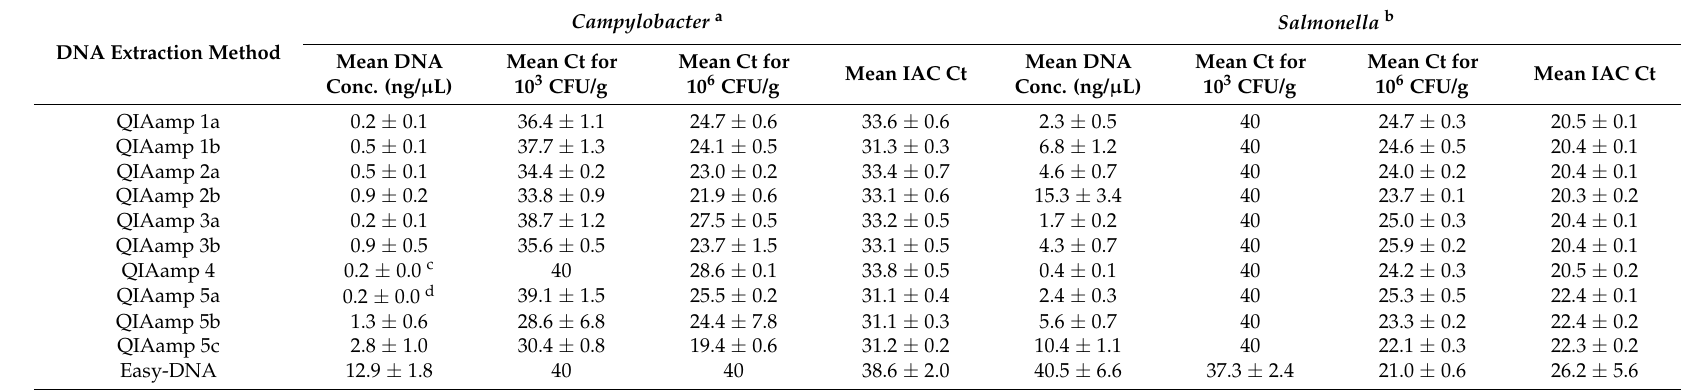
Table 2. Average DNA concentrations and quantitative PCR (qPCR)